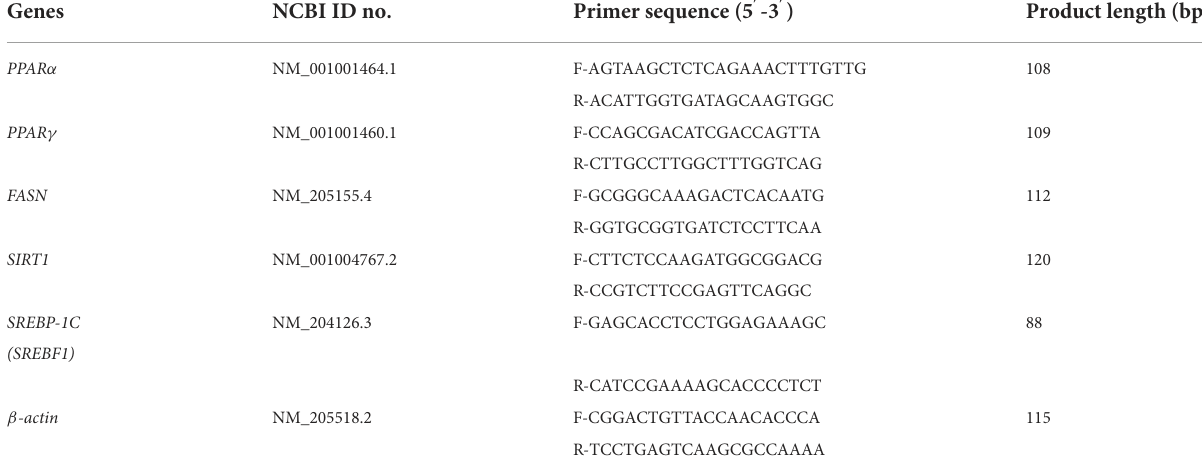
TABLE 2 List of gene primer sequences.